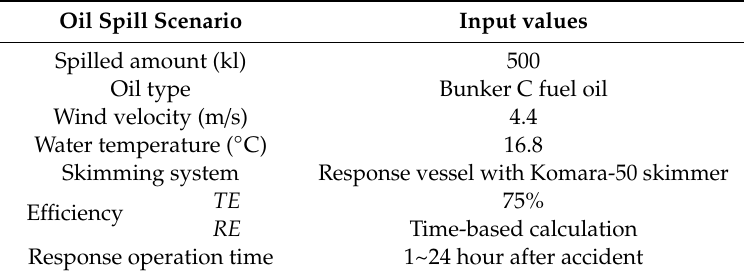
Table 1. Spill scenario of model comparison case